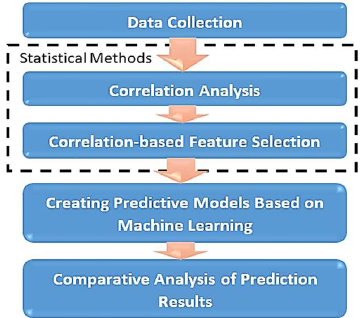
Figure 1. Methodological research procedure.